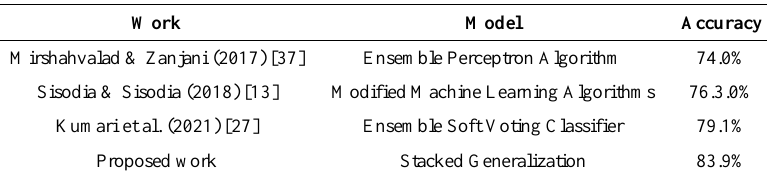
Table 8. Comparative